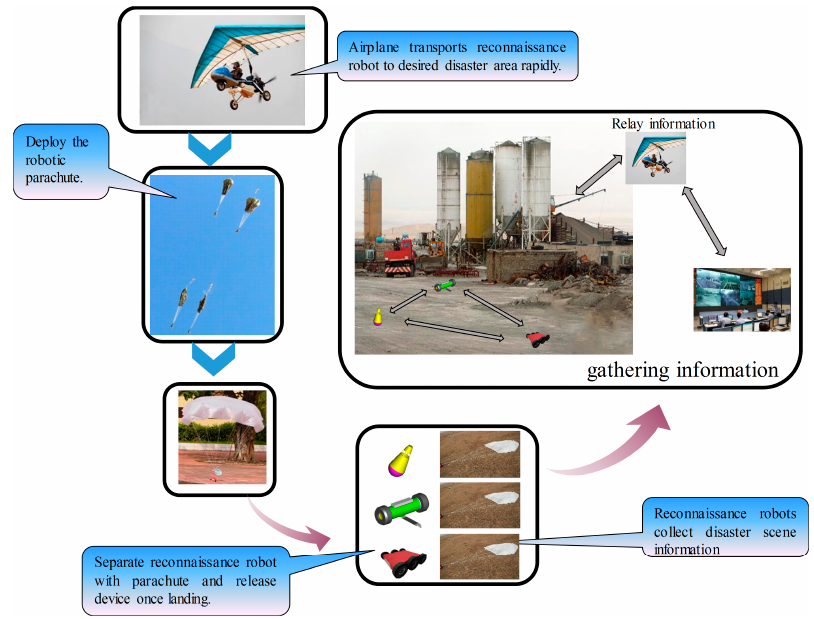
Figure 4. Flow chart of the proposed sensing mode.